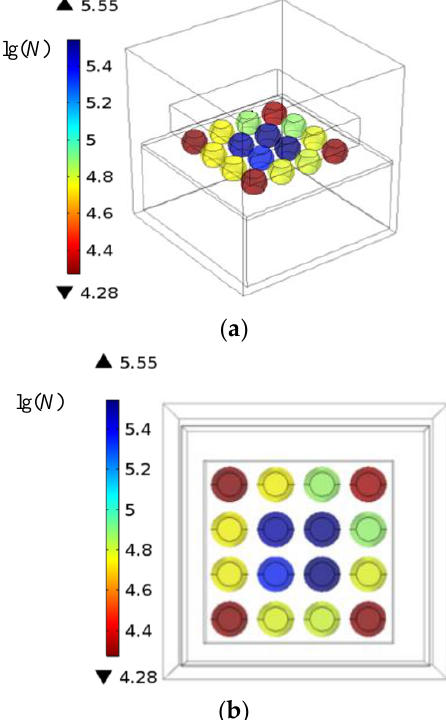
Figure 7. Thermal fatigue life distributions in the flip chip component under typical operating conditions: ( a ) three-dimensional view and ( b ) top view.